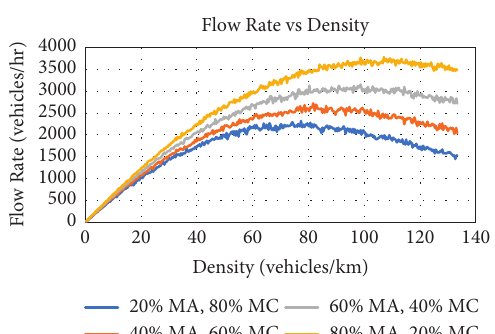
Figure 20: Flow rate vs. density fundamental diagrams for different compositions of MA and MC.